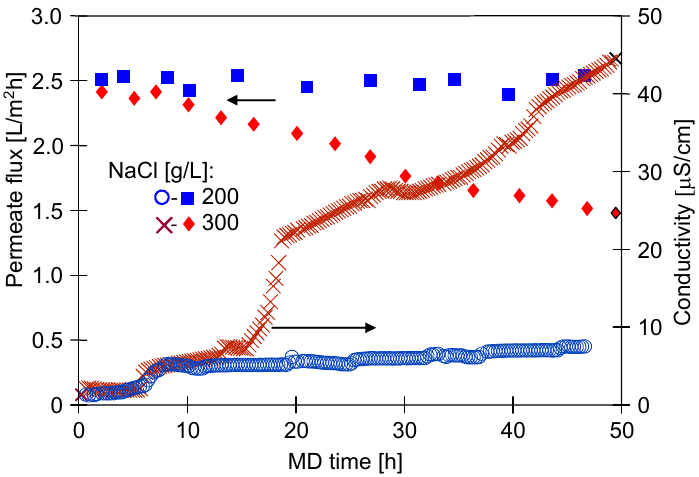
Figure 8. Changes in the permeate flux and distillate conductivity. Feed: NaCl solution (200 or 300 g/L) + oil (50–130 mg/L) + SDS (2 mg/L). Modules: CMD2 (200 g/L of NaCl) and CMD3 (300 g/L of NaCl).